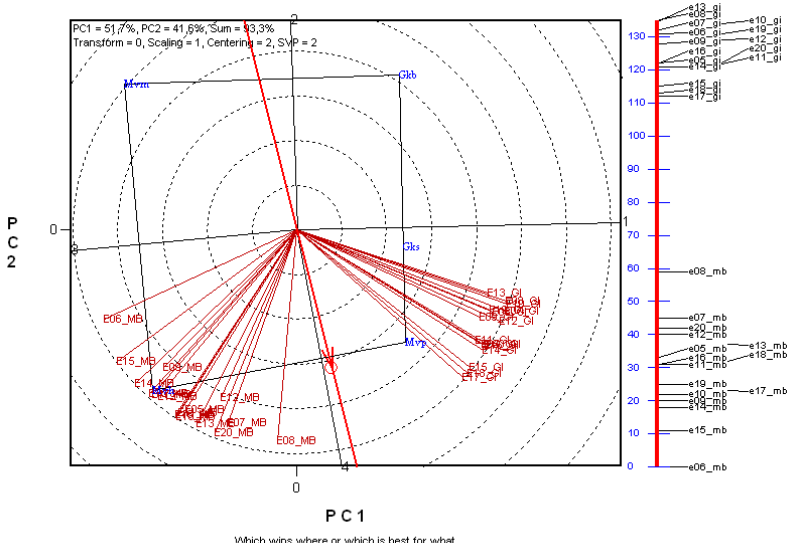
Figure 3. Correlations between years and winter durum wheat cultivars on the basis of gluten index (GI) and Minolta b* (MB) data over 16 years. Environment-centred (Centering = 2) GGE biplot analysis based on non-scaled data (Scaling = 0) with environment-metric (SVP = 2) plotting. E05–E20: years 2005–2020; ‘Gkb’, ‘Gks’, ‘Mvm’, ‘Mvp’, ‘Mvh’: genotypes; PC1, PC2: principal component variables; environment vectors are plotted with thin and the average environment axis (AEA) with a thick red line; O: year mean. The linear map of the environment vectors is shown on the right of the figure, where the scale represents the angle enclosed by the vectors, expressed as ◦ . Figure 4 allows the durum wheat cultivar with the best approximation to the ‘ideal’ genotype (in this case, with the best combination of the given traits) to be identified. The value of a genotype is determined by its distance from the theoretical genotype located in the middle of the concentric circles (best for all traits, with perfect stability). The closer the genotype is to this point, the better the combination of desired traits. According to this analysis, ‘MVP’ came closest to the ideal genotype, with the best combination of these traits. ‘GKS’ and ‘MVH’ were at approximately the same distance from the ideal, the former excelling chiefly for gluten strength, the latter for yellow pigment content. ‘MVM’ and ‘GKB’ was located at the greatest distance from the ideal genotype.